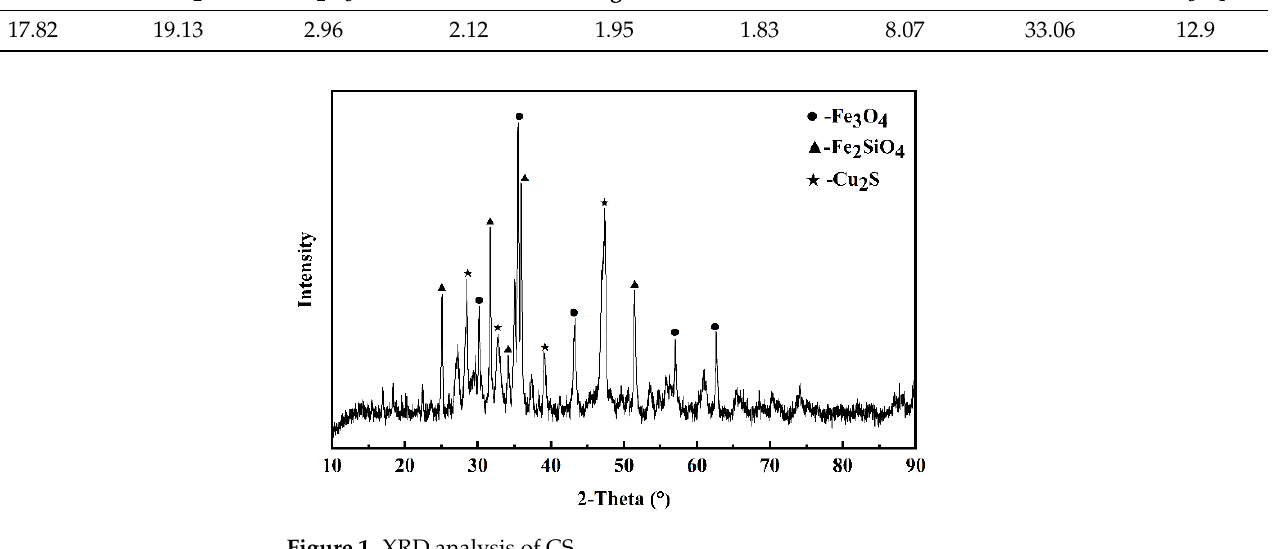
Figure 1. XRD analysis of